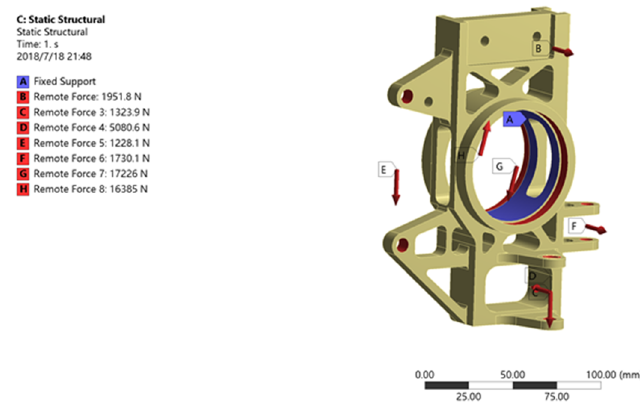
Figure 16. Strain cloud . 3.5.3. Analysis and verification of emergency turning conditions of front Figure 17. Finite element model. pillar. Figure 17. Finite element model.